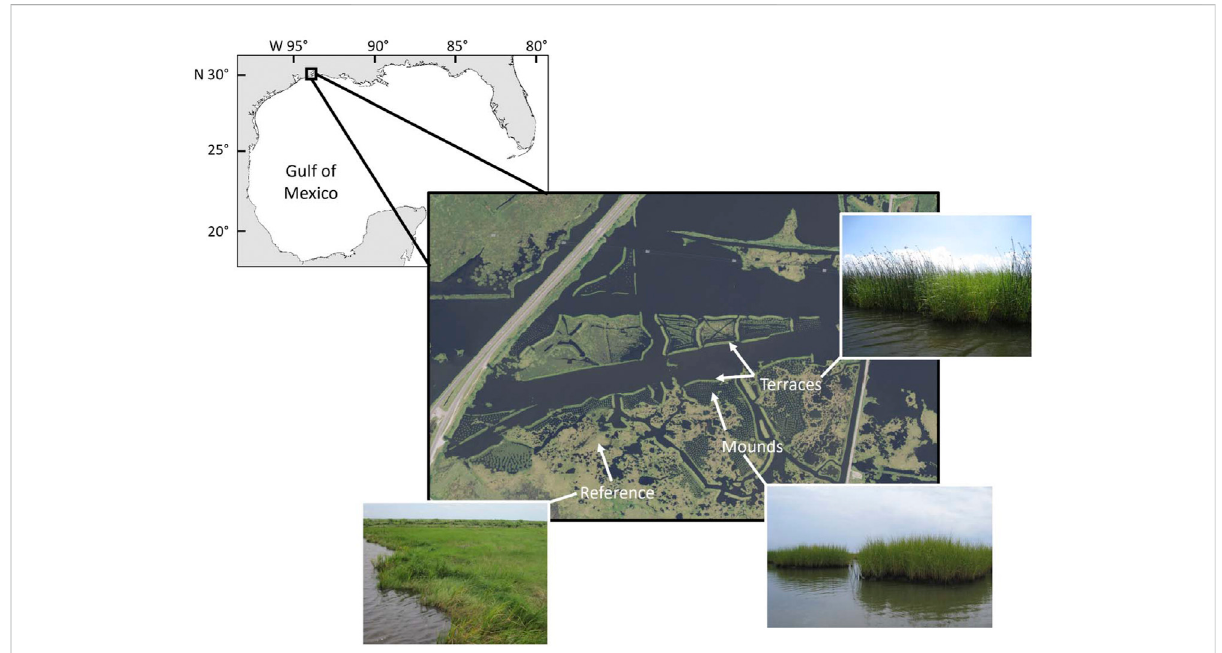
FIGURE 1 Map of study area in the Lower Neches Wildlife Management Area, depicting examples of restored mounds (planted with Spartina alterni fl ora ), restored terraces (planted with Spartina alterni fl ora and Schoenoplectus californicus ), and reference areas (primarily S. alterni fl ora , Spartina patens , and Bolboschoenus robustus ). Inset on upper left indicates study area location in the northern Gulf of Mexico. Aerial image obtained from the United States Department of Agriculture (USDA); Texas NAIP Imagery, 2016 –